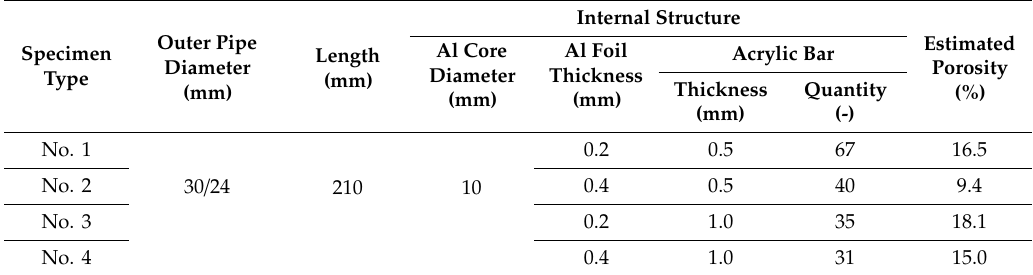
Figure 1. ( a ) Schematic preparation of the specimens and ( b ) experimental production assembly. Table 1. Physical properties of the prepared aluminium UniPore specimens.